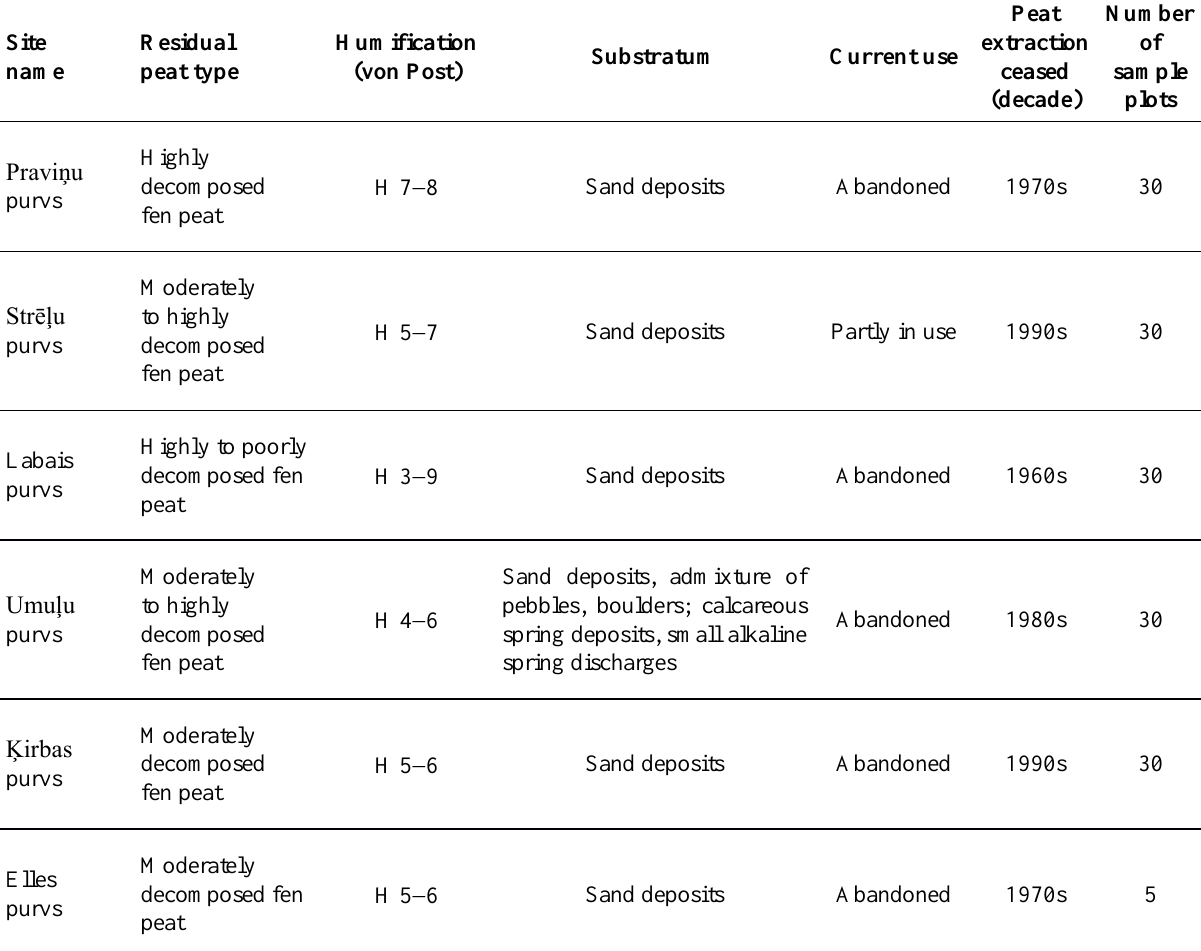
Table 1 Short description of the study